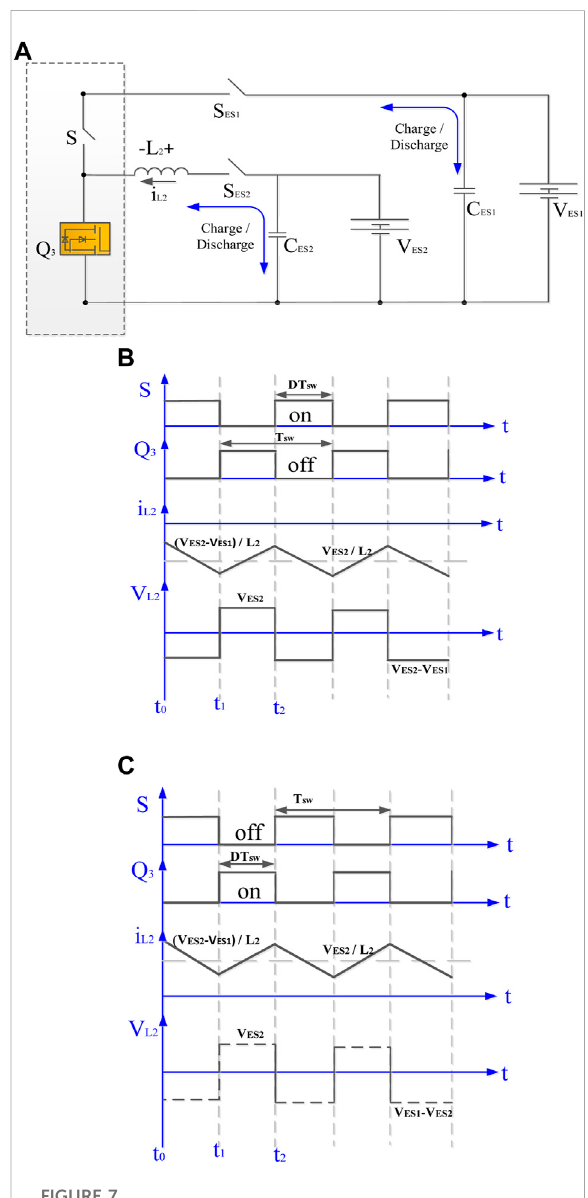
FIGURE 7 The proposed BDCC ’ s low voltage dual-source